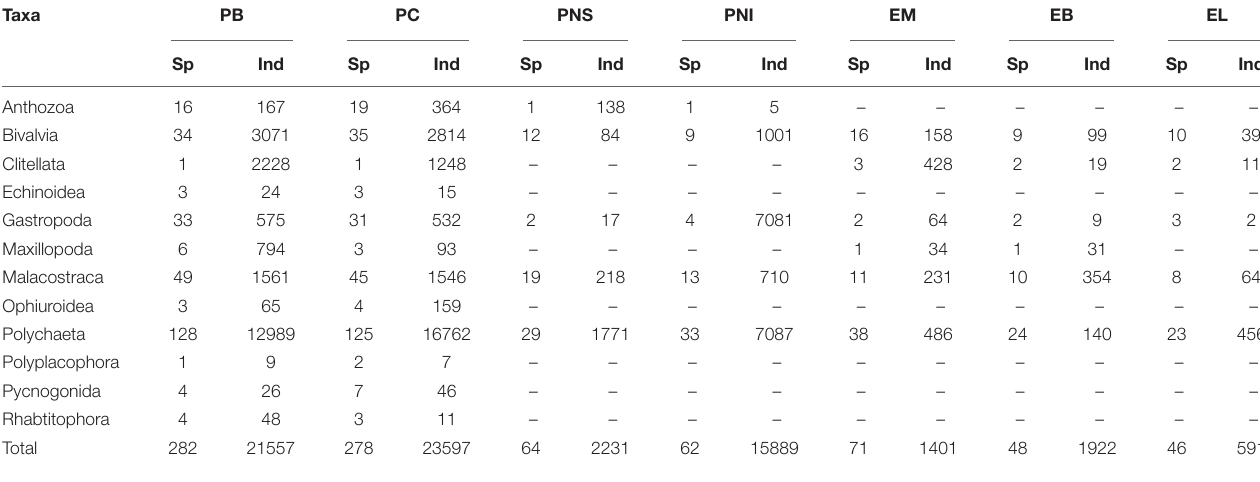
TABLE 1 | Main taxa groups of benthic macroinvertebrates, number of taxa (Sp), and number of individuals (Ind) collected in the summer season at: Porto do Buxo (PB) and Portinho da Costa (PC) during the sampling period (2002–2010); Parque das Nações subtidal (PNS) and Parque das Nações Intertidal (PNI) during the sampling period (1998–2003); and Estuary Middle (EM); Estuary Bays (EB); and Estuary Lower (EL) during the sampling period (2003 and